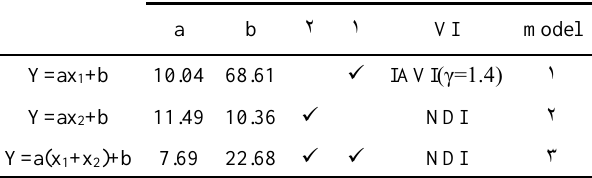
Table 4. Selected models